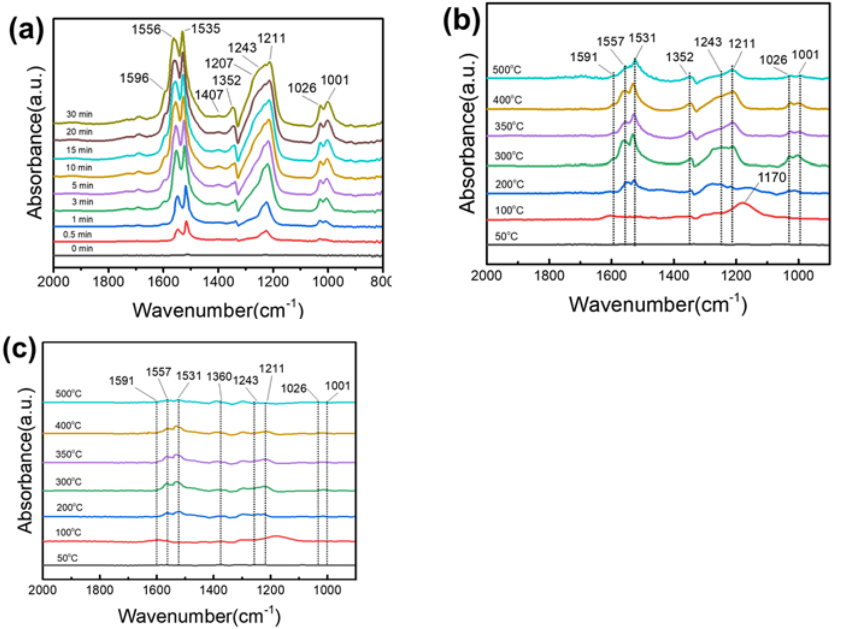
Figure 11. The in situ DRIFTS spectra of NOx adsorption over CeONB at ( a ) different times (350 °C)